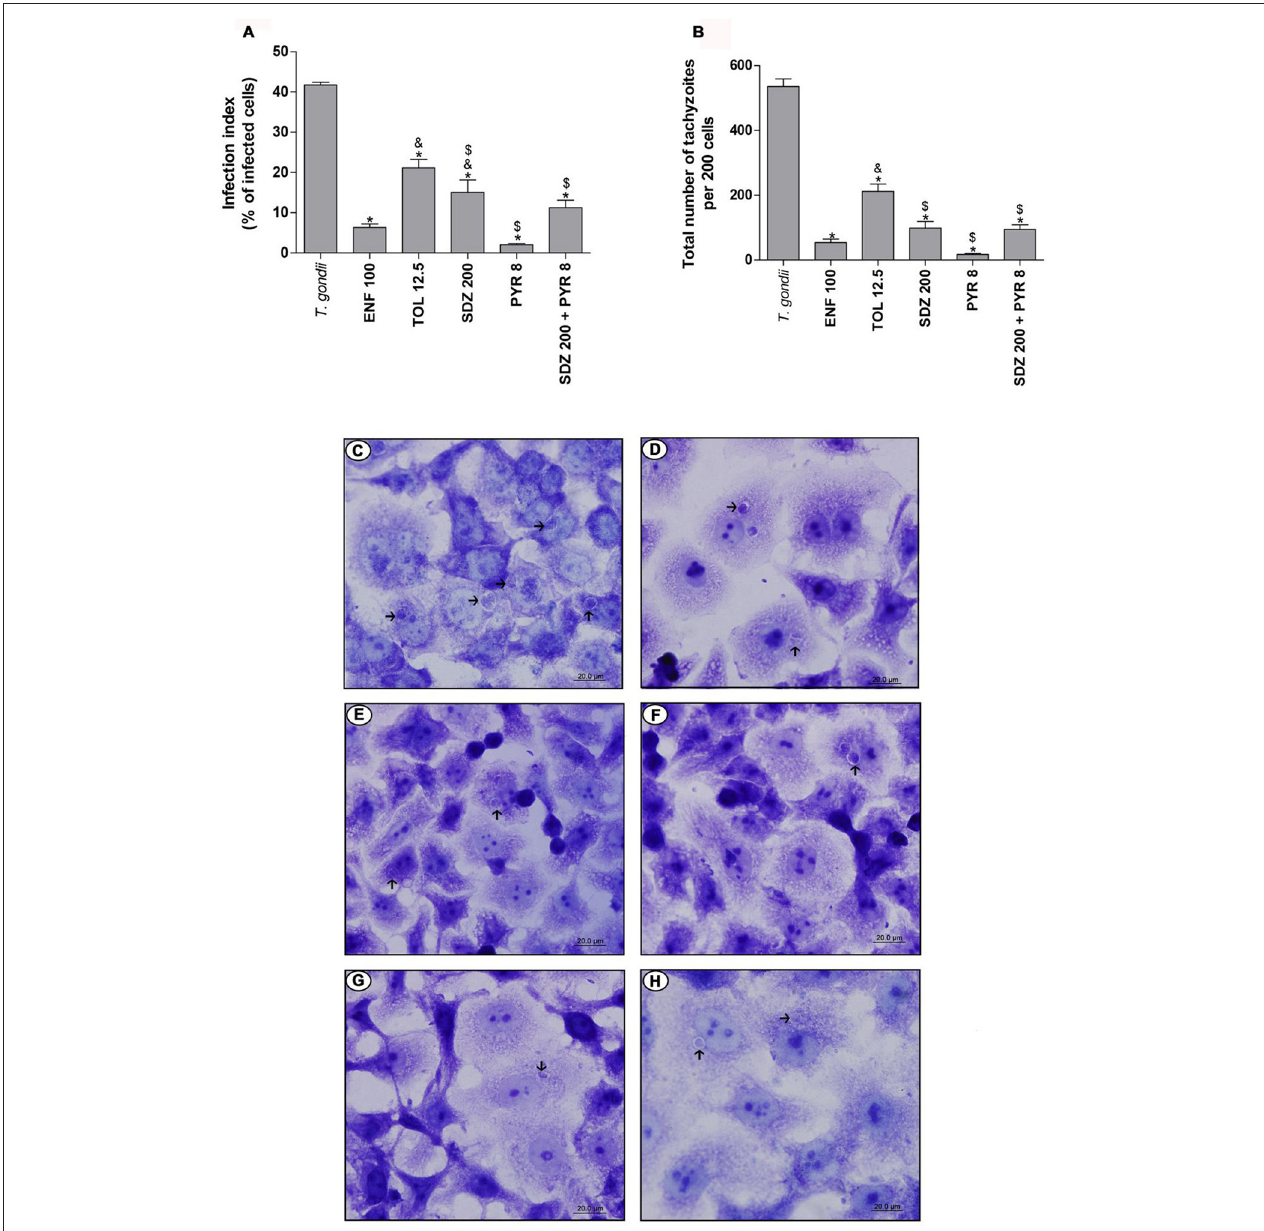
FIGURE 3 | T. gondii infection (ME49 strain) in BeWo cells treated with different drugs . BeWo cells were cultured on round glass slides of 13mm in 24-well plates (1 × 10 5 cells/200 µ L) for 24h, infected with T. gondii (ME49 strain) for 3 h, washed with medium to remove extracellular parasites and treated or not with the different drugs ( µ g/mL): enrofloxacin (ENF), toltrazuril (TOL), sulfadiazine (SDZ), pyrimethamine (PYR), or combination of sulfadiazine plus pyrimethamine (SDZ + PYR) for an additional 24h. Then, the cells were stained with 1% toluidine blue and counted using a light microscope. Data obtained were analyzed as infection index (% of infected cells) (A) and total number of tachyzoites (total number of tachyzoites per 200 cells) (B) . Data were shown as mean ± SEM from three independents experiments in six replicates. Significant difference in relation to infected and untreated cells ( T. gondii ) ( ∗ P < 0.05), ENF ( & P < 0.05), and TOL ( $ P < 0.05). Differences between groups were analyzed by One-Way ANOVA with the Bonferroni multiple comparison post-hoc test. Representative photomicrographs of BeWo cells infected by T. gondii and untreated (C) , or treated with ENF (D) , TOL (E) , SDZ (F) , PYR (G) , or combination of SDZ + PYR (H) . Staining by blue toluidine. Arrows indicate parasites into parasitophorous vacuole. Bar scale: 20.0 µ